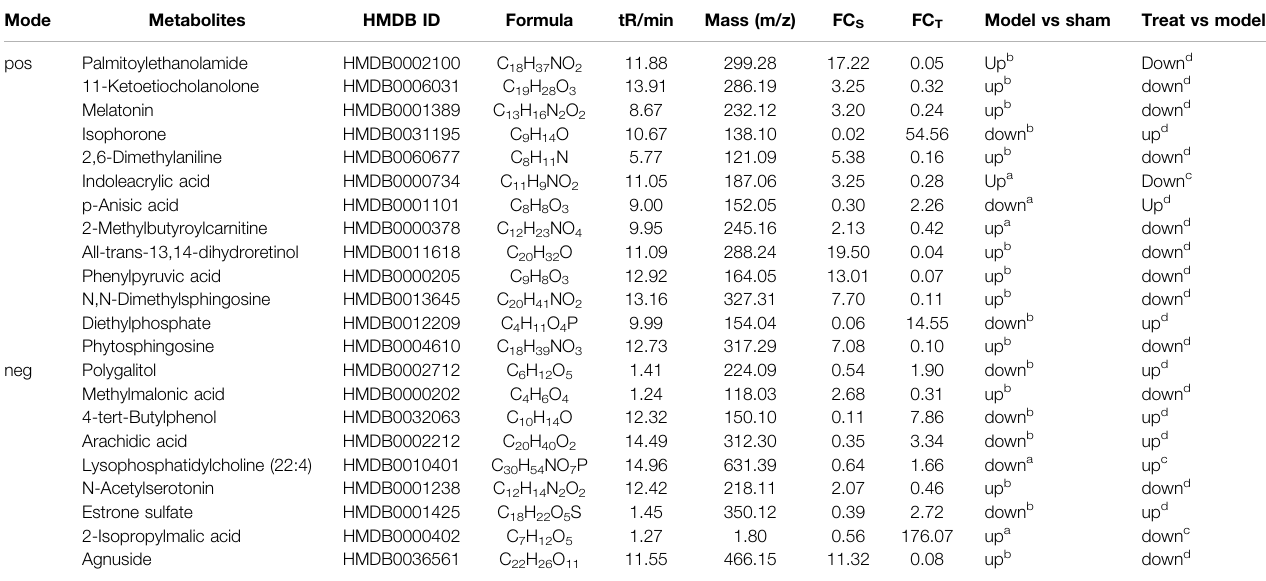
TABLE 1 | Potentiale biomarkers associated with GXSTC treatment in rat plasma in positive mode and negative